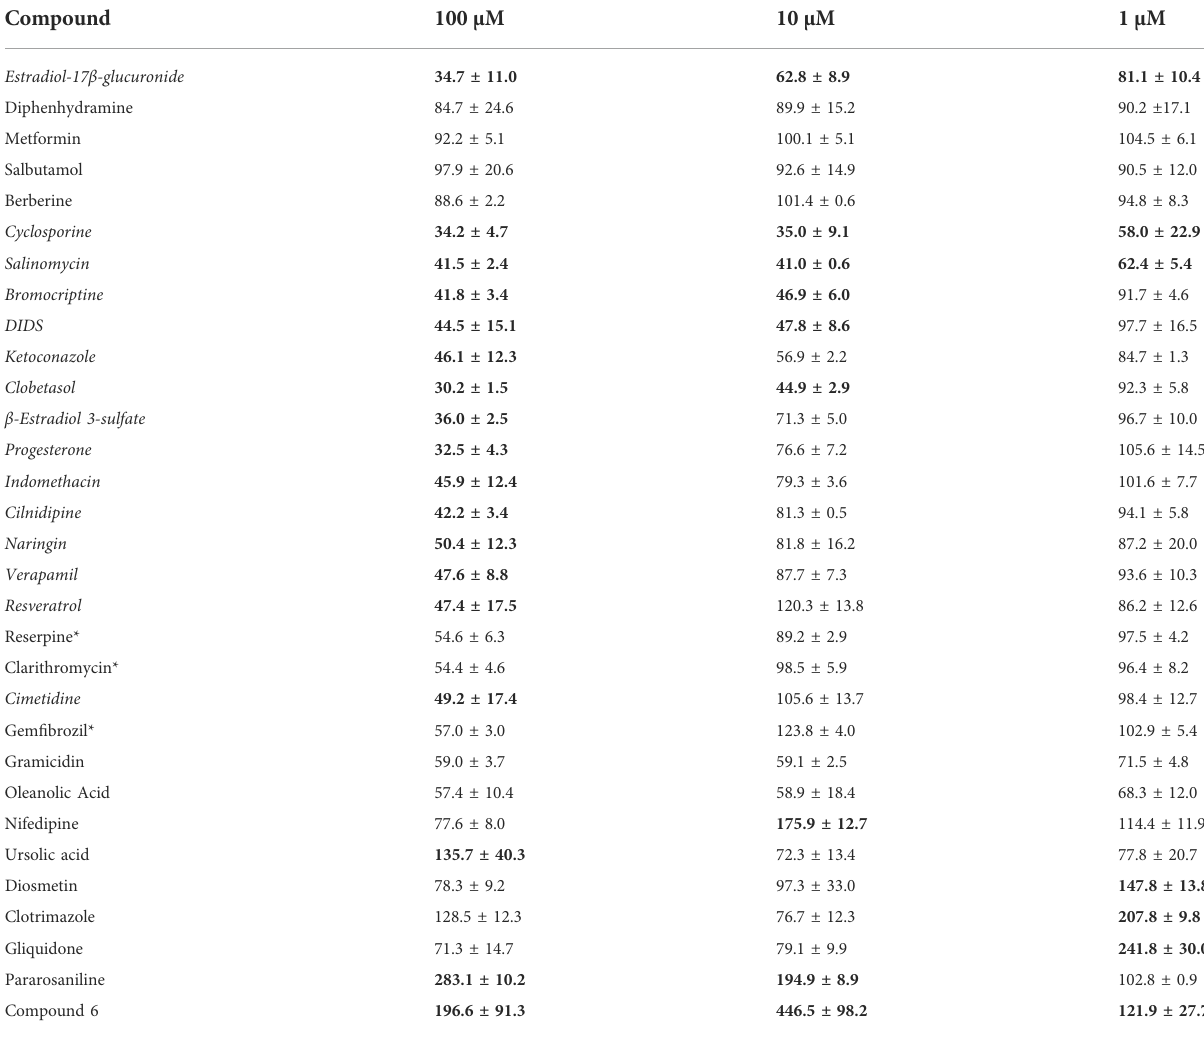
TABLE 2 Concentration-dependent ef fl ux of [ 3 H]-estradiol-17 β -glucuronide from OATP1B3-expressing CHO cells, stimulated by common OATP inhibitors.